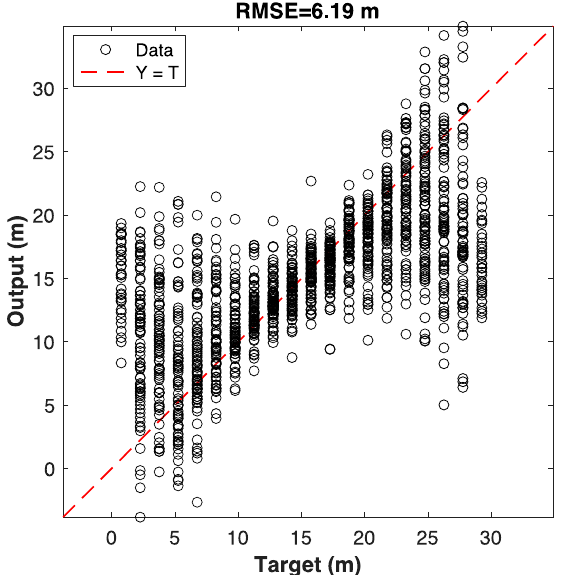
Figure 5. Regression plot related to a freq = 0.001 Hz and a rot = 0.001°. RMSE: root-mean-squared error. The same analysis was repeated, varying the accuracy variables in the aforementioned range.